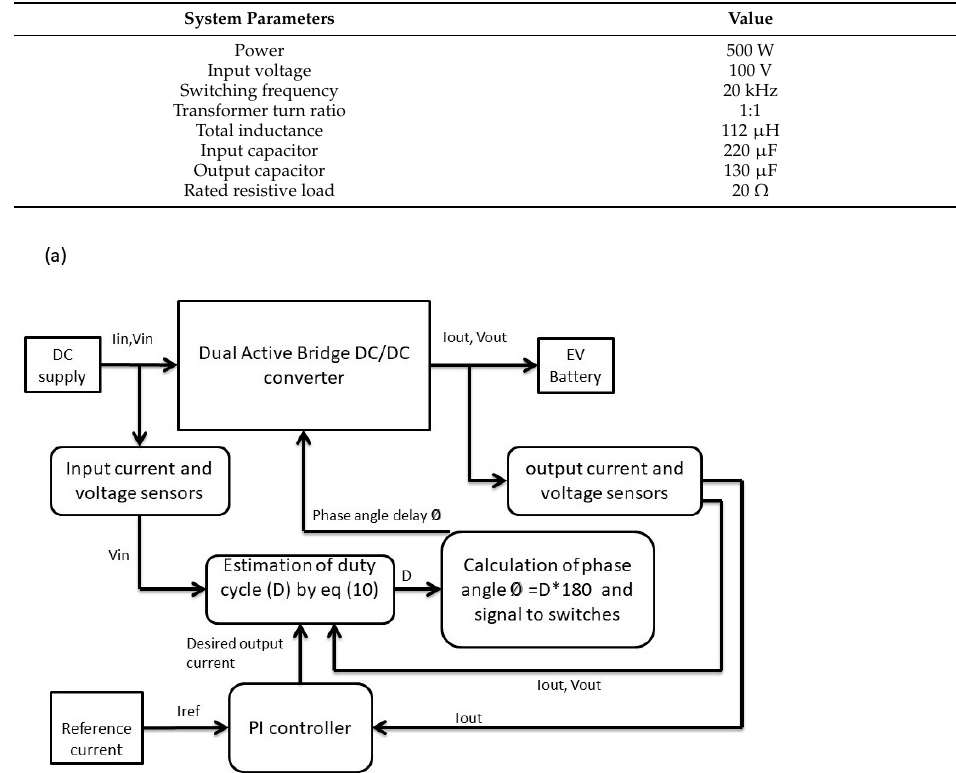
Table 1. DAB–DC/DC electrical specifications used for MATLAB simulation.